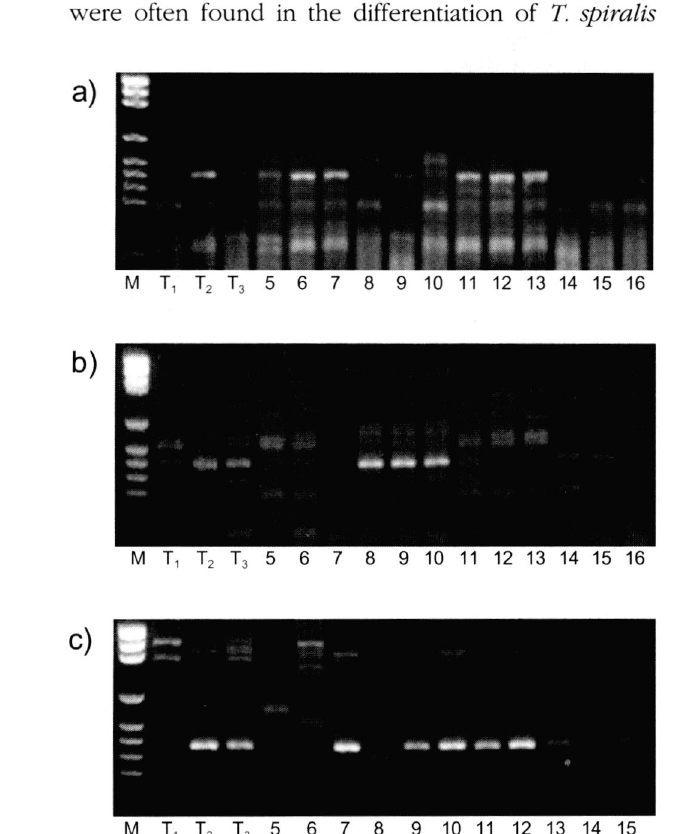
Fig. 1. - a-c: Examples of RAPD-PCR patterns obtained with crude preparations of individual Trichinella muscle larvae. Lanes: M: 100 bp ladder (PGEM); Reference larvae: Tl, Trichinella spiralis (ISS4), T2: